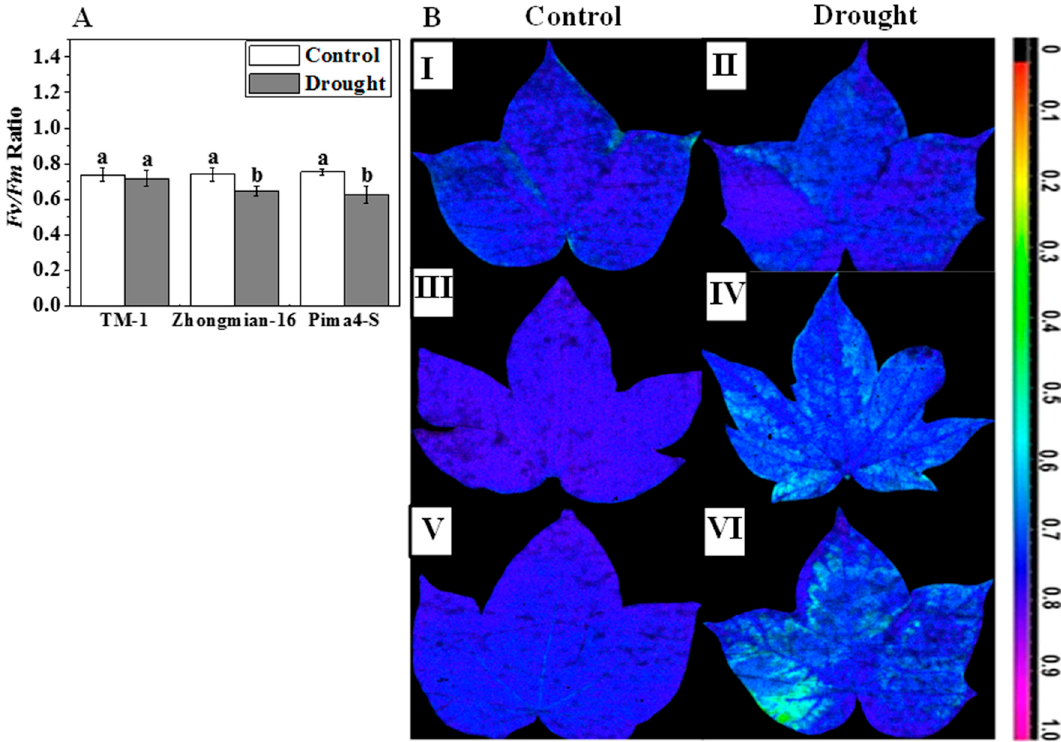
Figure 3. Effect of drought stress on F v / F m Ratio ( A ) of the second fully expanded leaves in three cotton species. Means denoted by the same letter are not significantly different at p < 0.05. Error bars are ± SD ( n = 4); Conversely, false color image ( B ) application was used to understand changes of F v / F m ratio where I, III, V (control) and II, IV, VI (drought treated) leaves of TM-1, Zhongmian-16, and Pima4-S, respectively. In comparison with the control, leaf color shifted from violet blue to light blue along with reducing the F v / F m ratio. The false-color scale depicted the image ranges from 0.2 (yellow) to 1.0 (purple).